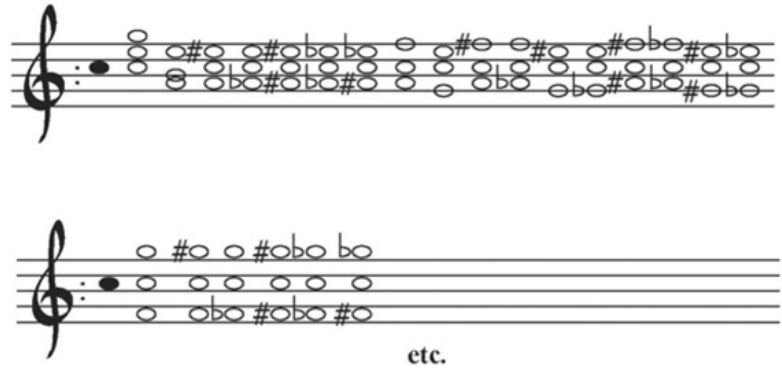
FIGURE 13 . The theoretical possibilities for triads that contain the tone